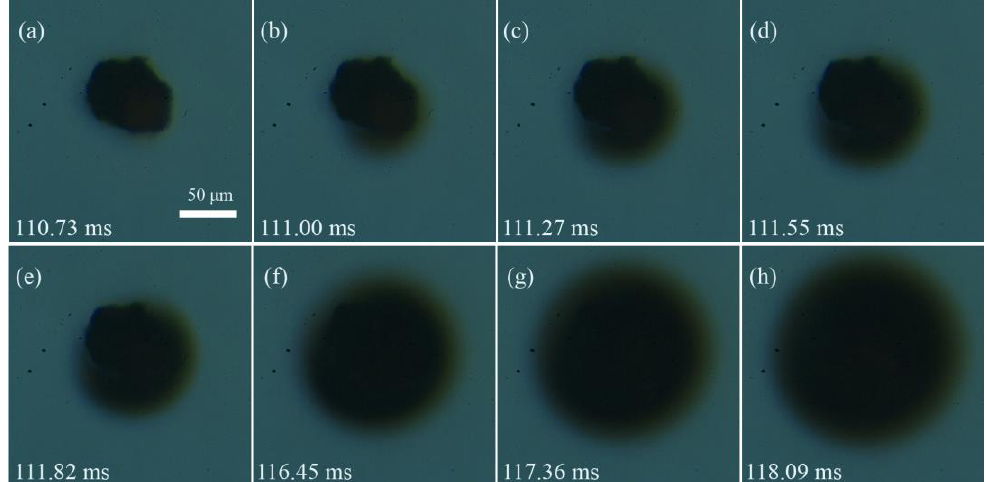
Figure 9. Representative snapshots of gasification stage of individual Mg microparticle. (Images acquired from Supplementary Materials, Video S1, recording frame: 11,000 fps; exposure time: 99 μs). ( a ) 110.73 ms, ( b ) 111.00 ms, ( c ) 111.27 ms, ( d ) 111.55 ms, ( e ) 111.82 ms, ( f ) 116.45 ms, ( g ) 117.36 ms, ( h ) 118.09 ms.